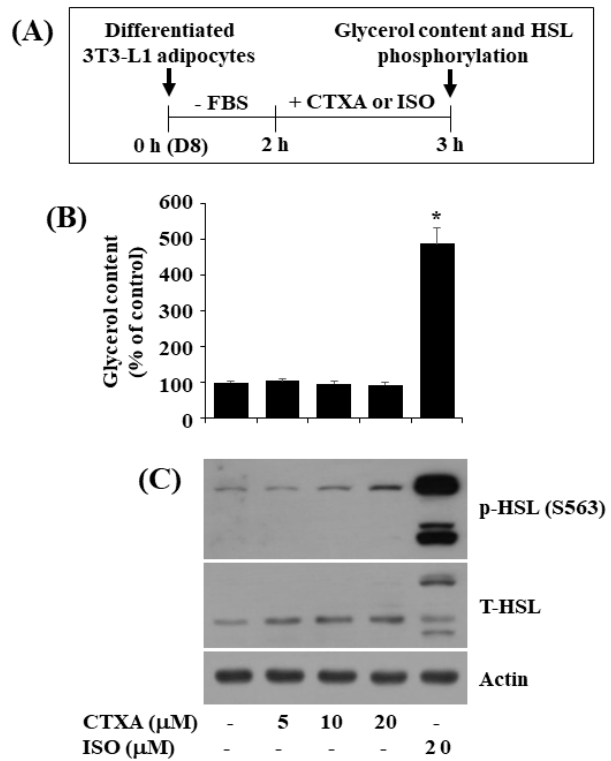
Figure 5. Effects of CTXA on glycerol release and expression and phosphorylation level of hormone-sensitive lipase (HSL) in differentiated 3T3-L1 cells. ( A ) The experimental scheme for measurement of glycerol content and HSL phosphorylation in differentiated 3T3-L1 cells. ( B ) Differentiated 3T3-L1 cells on D8 (0 h) were serum-starved for 2 h and then grown in the absence (control; 0.1 % DMSO) or presence of CTXA (5, 10, and 20 µM) or isoproterenol (ISO) (10 µM) for an additional 3 h. Glycerol content in culture medium from control or drug (CTXA or ISO)-treated cells was analyzed in triplicate. Data are mean ± SE of three independent experiments. * p < 0.05 vs. control. ( C ) After the treatment mentioned above in ( A ),